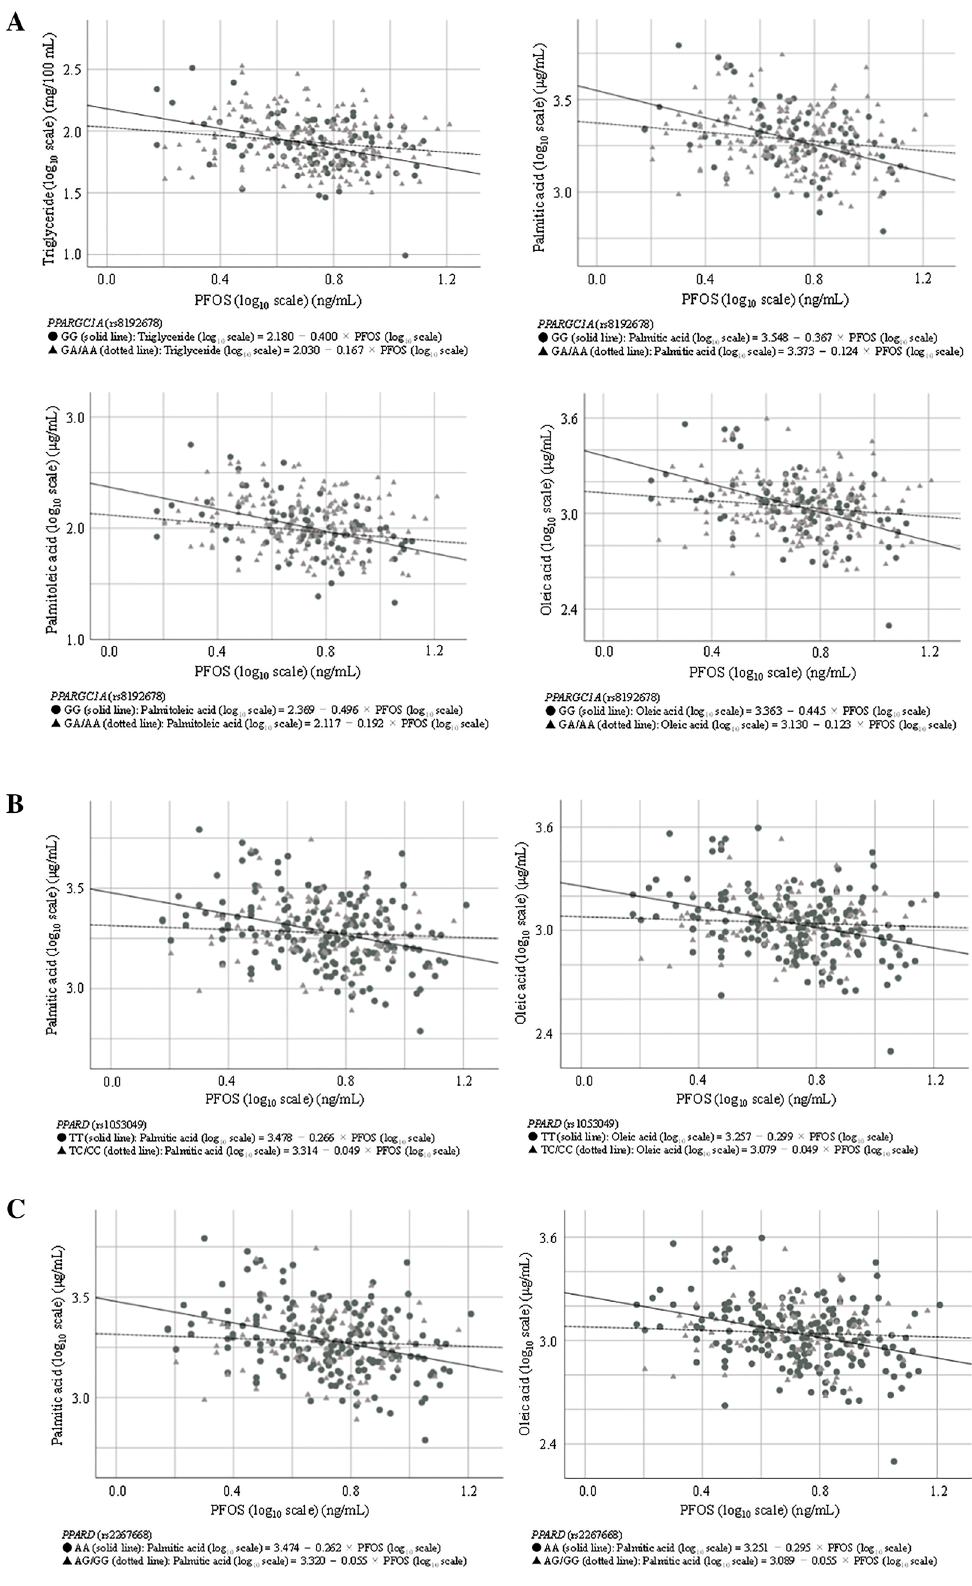
Figure 1. Plot of gene-environment interaction between ( A ) PPARGC1A (rs8192678), ( B ) PPARD (rs1053049), and ( C ) PPARD (rs2267668) and PFOS levels on fatty acid levels in